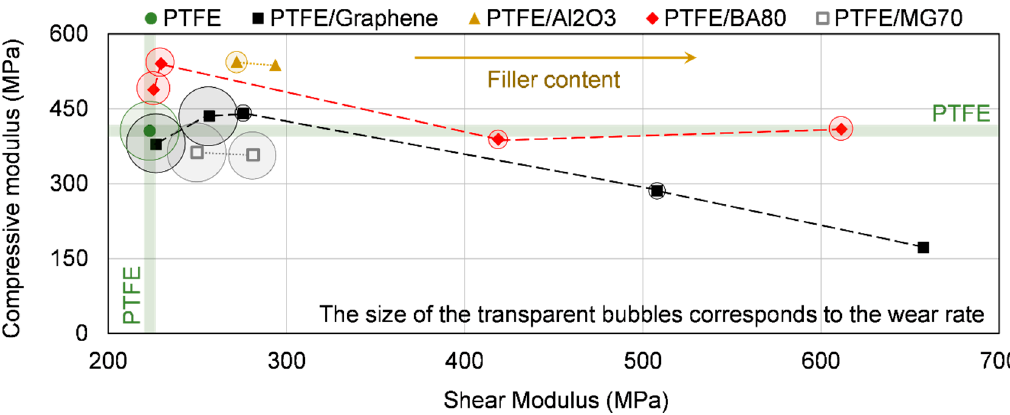
Figure 10. Compressive modulus as a function of the shear modulus of unfilled and filled PTFE samples. The size of the bubbles correlates to the wear rate of the samples.